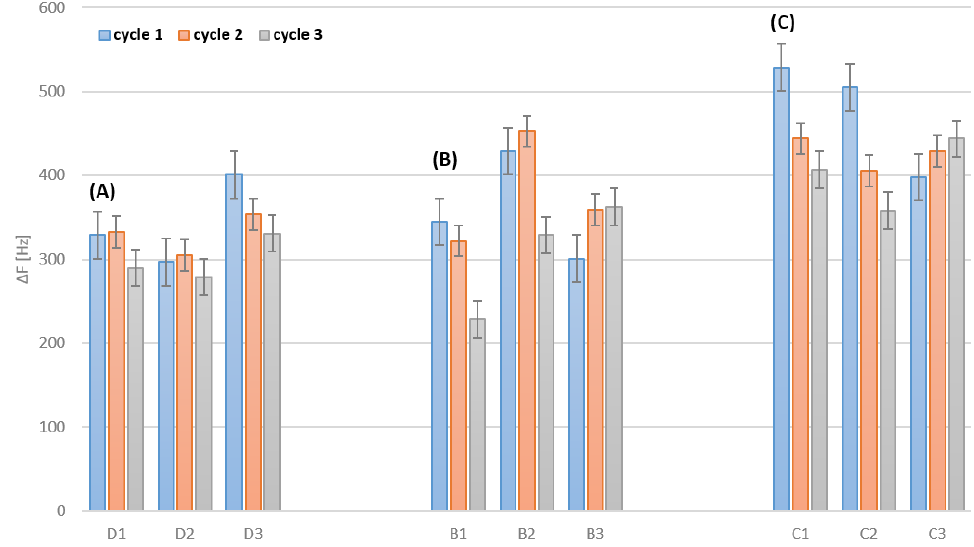
Figure 3. Changes in resonant frequencies [Hz] of QCM electrodes with peptide-based films after different cleaning techniques: ( A ) electrochemical (D1—hydrochloric acid potential cycling, D2—sulphuric acid potential cycling, D3—potassium hydroxide potential sweep), ( B ) plasma and ( C ) Piranha. Error bar indicates the calculated standard deviation (n − 3). Table 2. Response of QCM transducers after OBPP4 peptide immobilization and after cleaning with selected techniques .